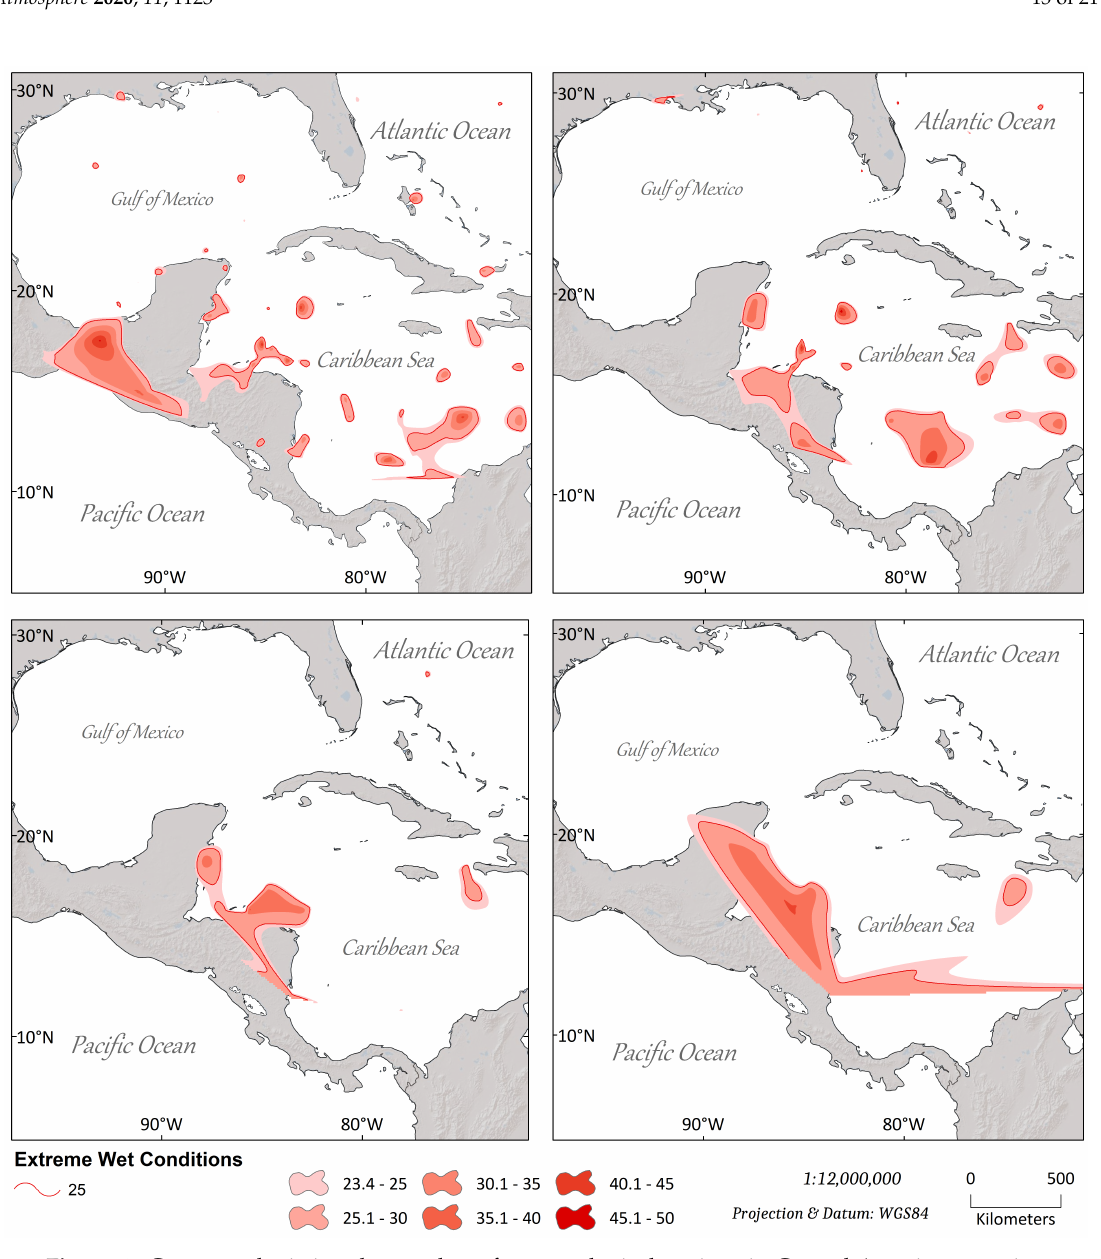
Figure 4. Contours depicting the number of meteorological stations in Central America reporting extreme precipitation events (above 90th percentile) plotted in the median corresponding daily location of the Caribbean cyclones. The category of the cyclone was determined from the median category identifier number of the hourly data of each day. Data from 1970 to 2010. ( upper left ) All cyclones, ( upper right ) named cyclones, ( lower left ) all hurricanes, ( lower right ) intense